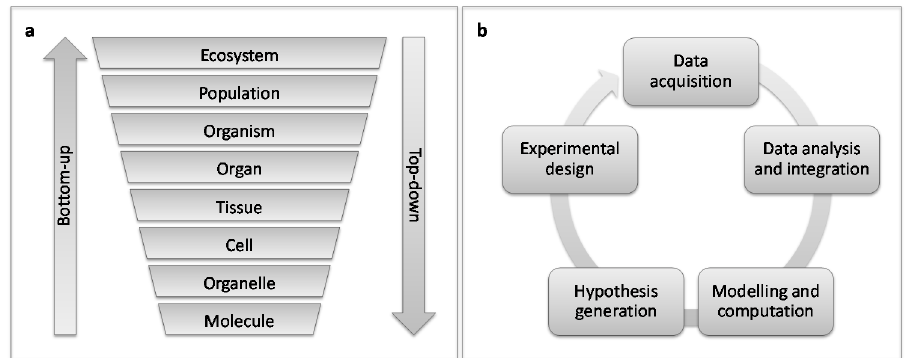
Figure 1. Concepts in systems biology approaches. ( a ) Holistic (top-down) vs. reductionist (bottom-up) approaches to study and integrate the various levels of biological systems; and ( b ) an iterative process that is used to generate data and model a biological system.